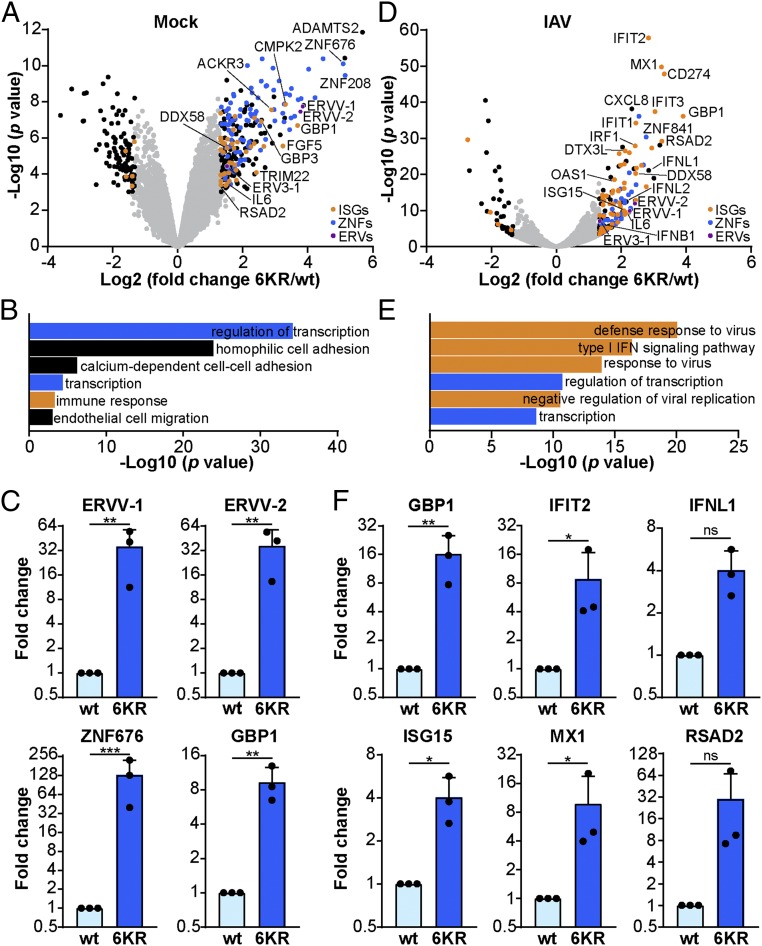
Cells expressing SUMOylation-deficient TRIM28 exhibit an increased innate immune defense gene signature and are primed for triggering enhanced IFN-stimulated responses during infection. (A and D) Transcriptome analysis comparing TRIM28-KO A549 cells reconstituted with wt TRIM28 or TRIM28-6KR, which were mock infected (A) or infected with IAV (MOI = 10 PFU per cell, 6 h) (D). Data are derived from 3 independent replicates. Genes with a P < 0.001 and fold change 6KR/wt >2.5 or <−2.5 are depicted in blue (zinc finger proteins), orange (IFN-stimulated genes), purple (ERVs), or black (others). ISGs were identified using an online database [http://isg.data.cvr.ac.uk (62)]. (B and E) GO pathway enrichment analysis of genes significantly up-regulated (P < 0.001 and fold change > 2.5) in cells expressing TRIM28-6KR under mock (B) or infected (E) conditions, showing the 6 most significantly enriched pathways. (C and F) Differential expression of selected genes was validated by RT-qPCR analysis under mock (C) or IAV infection (F) conditions as described in A and D. Bars represent mean values and SDs of 3 independent experiments (each dot represents 1 replicate). Significance was determined by unpaired t test (*P < 0.05, **P < 0.01, ***P < 0.001; ns, nonsignificant). See also Datasets S5 and S6.